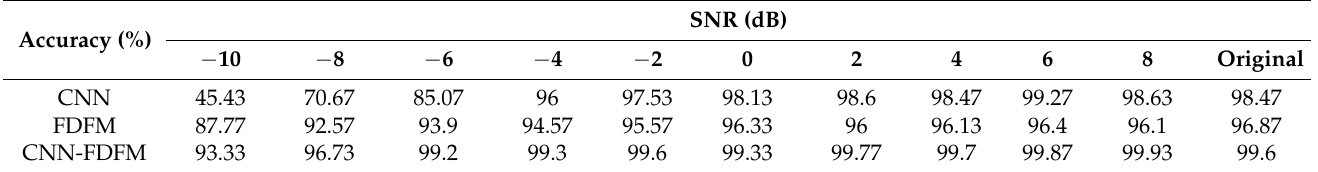
Table 5. Diagnosis results of CNN, FDFM and CNN-FDFM under different SNRs. SNR Accuracy (%)